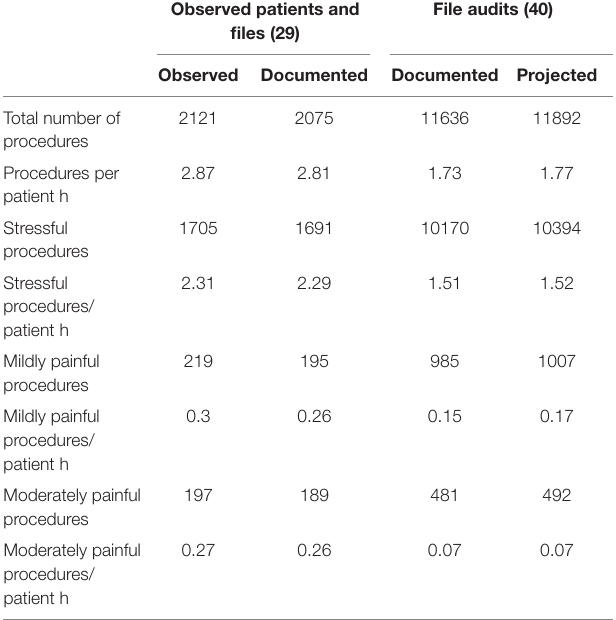
TaBle 3 | Procedure documentation data.